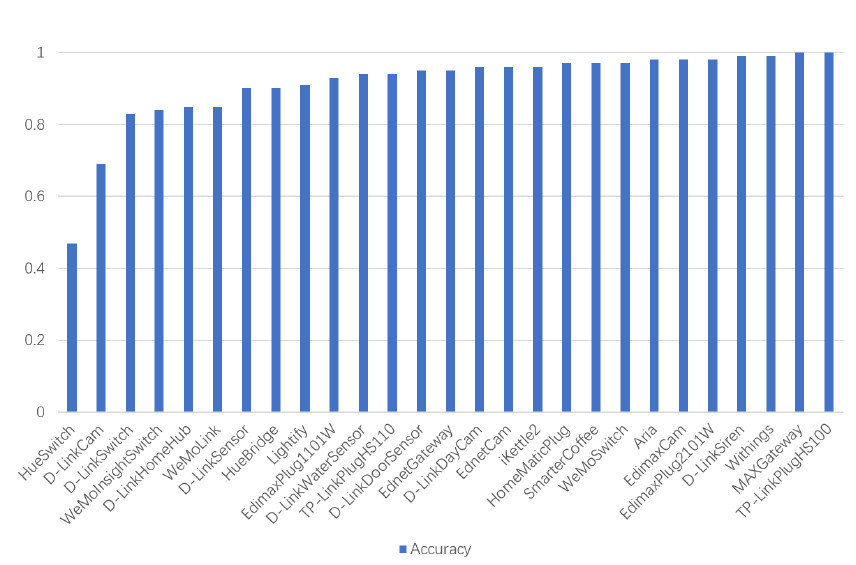
Figure 7. The accuracy of detecting fraudulent use of device identity.